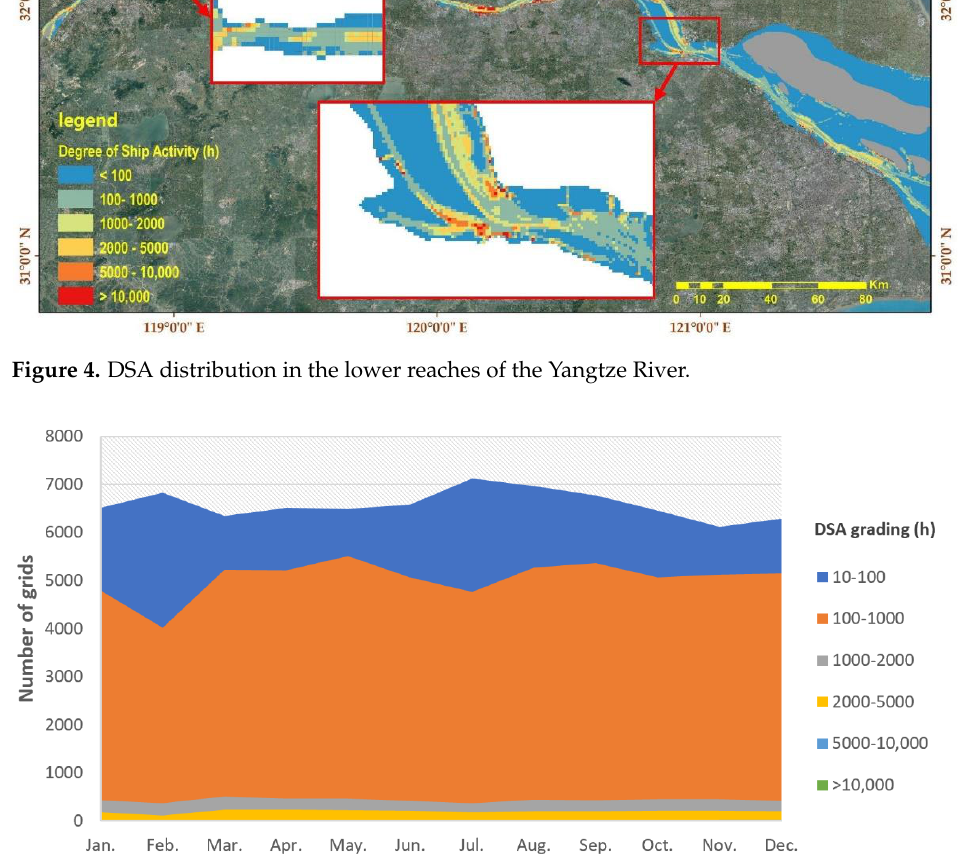
Table 2. Generation of ship water pollutants in the lower reaches of the Yangtze River (t/a). Sewage